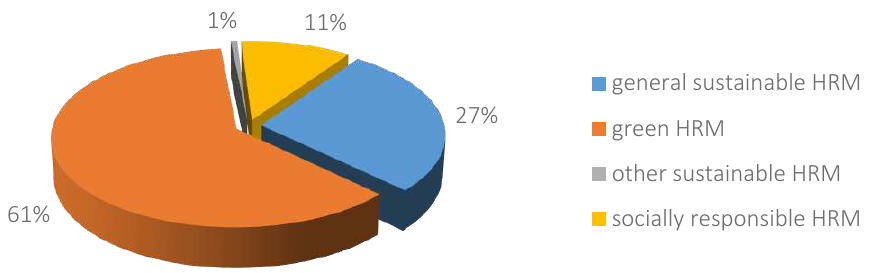
Figure 3. Sustainable HRM literature per type from 2006 to